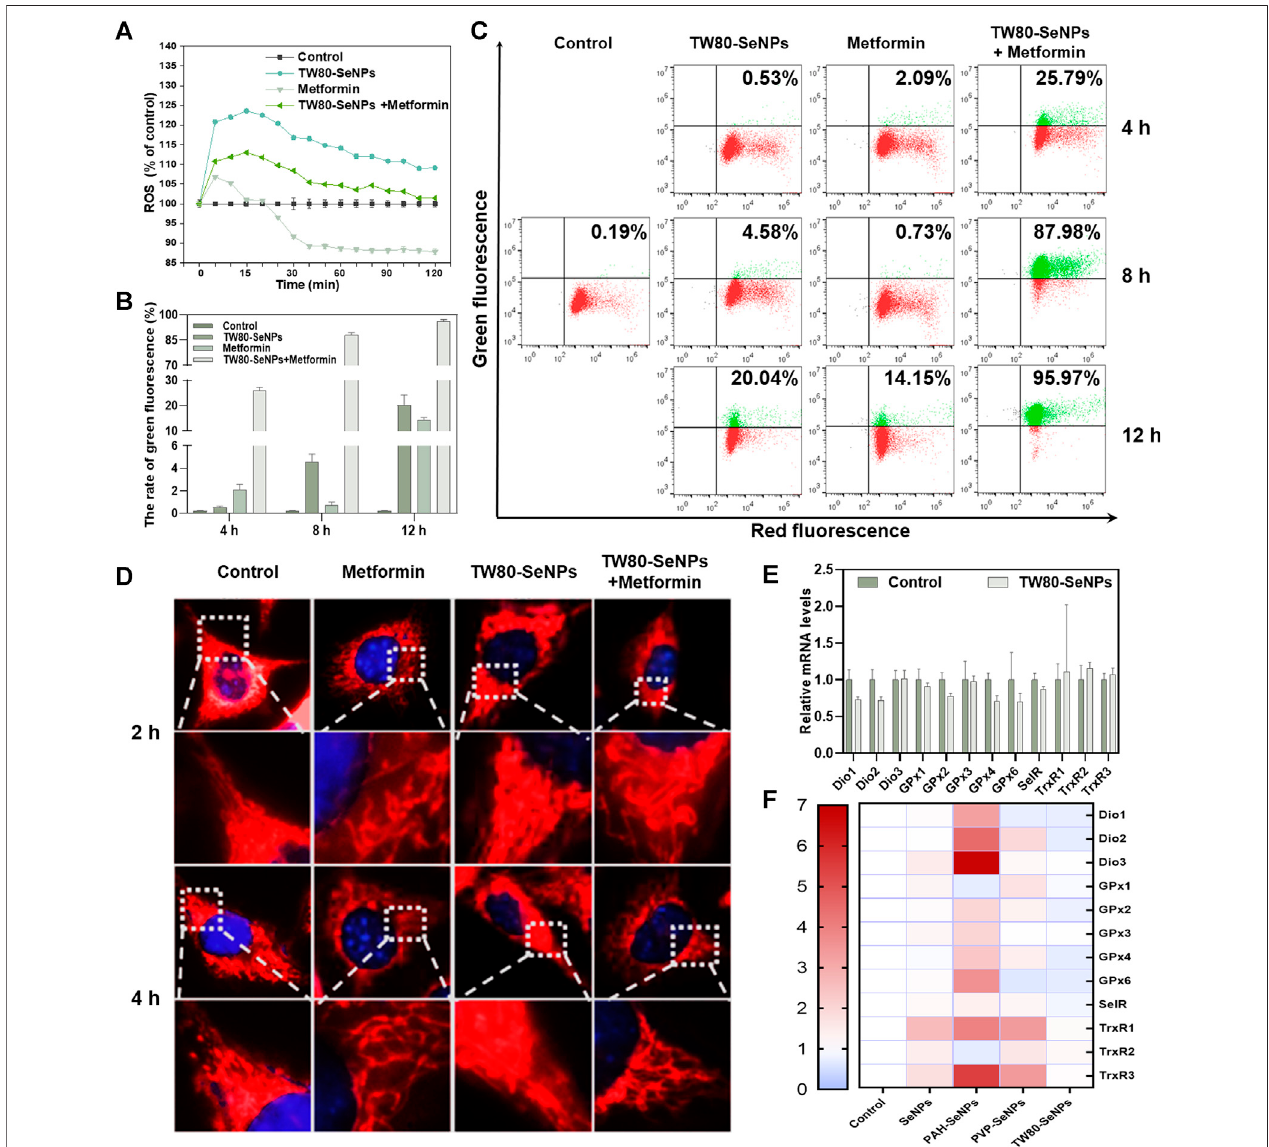
FIGURE5| ChangesofROSlevels,mitochondrialmorphology,mitochondrialmembranepotentialandexpressionlevelsofselenoproteinsinMCF-7cells. (A) ROS levels in MCF-7 cells treated with TW80-SeNPs (40 μ M) and metformin (10 mM). (B) and (C) Mitochondrial membrane potential of MCF-7 cells treated with TW80- SeNPs (40 μ M) and metformin (20 mM) at different time points. (D) Mitochondrial morphology and representative magni fi ed images of MCF-7 cells treated with TW80- SeNPs (40 μ M), metformin (20 mM) and co-administration at different time points. (E) and (F) Expression levels of selenoproteins in MCF-7 cells after different